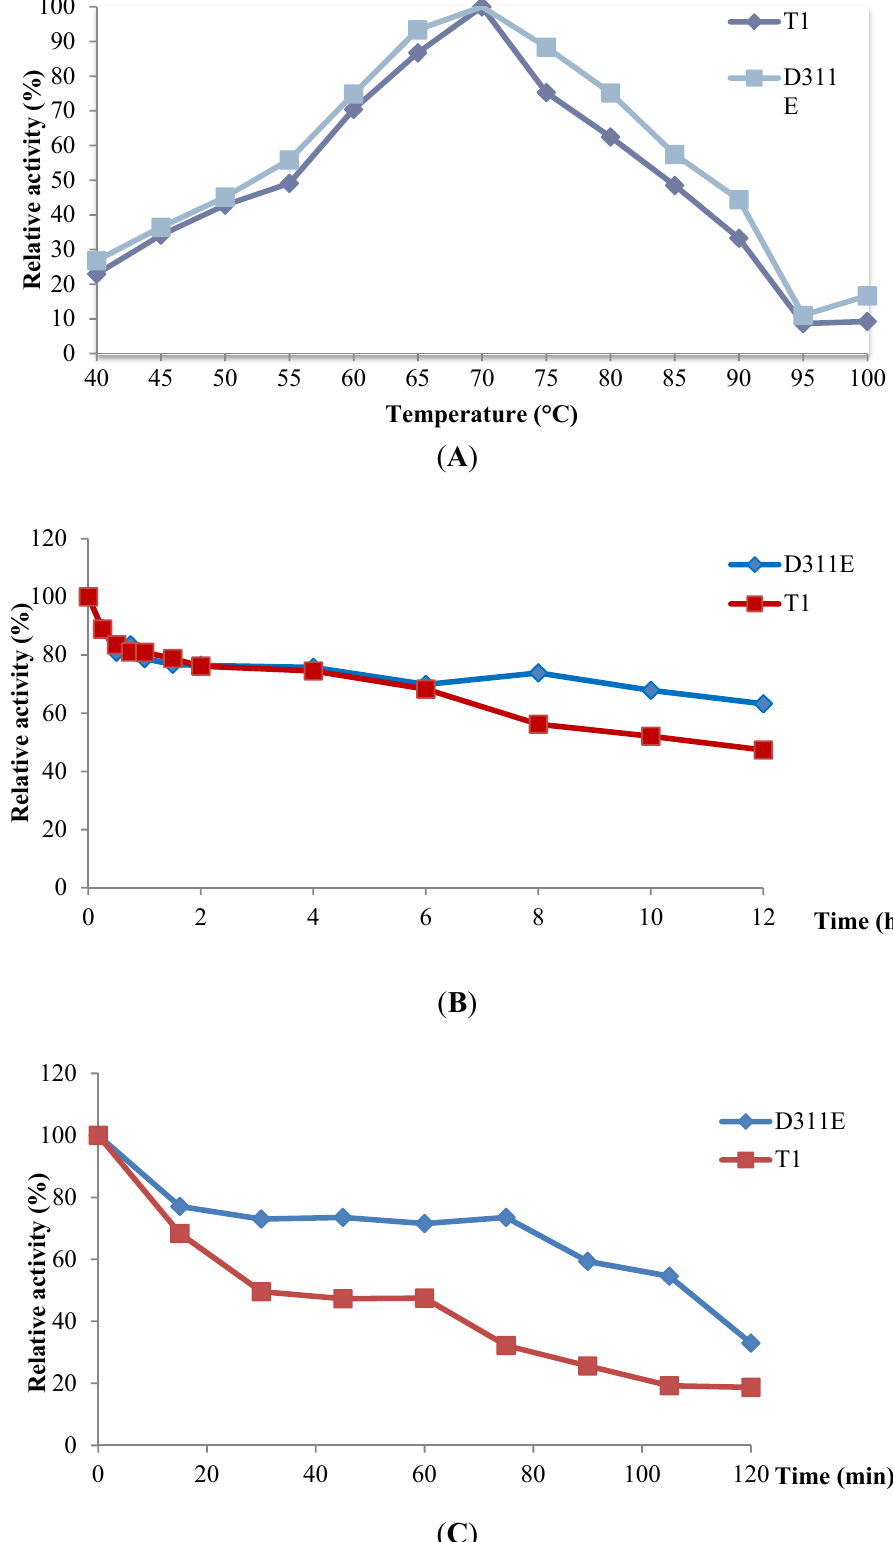
Figure 4. Effect of temperature on D311E and T1 lipase activity and stability. ( A ) The optimum temperature of D311E and T1 lipase; ( B ) Effect of temperature on lipase stability, pre-incubated at 70 °C; ( C ) Effect of temperature on lipase stability, pre-incubated at 60